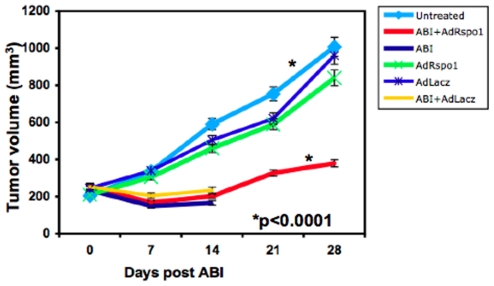
AdRspo1 treatment has no effect on tumor growth.Effect of AdRspo1 and AdLacZ treatment on tumor growth rate of Balb/c mice (n = 5) irradiated with 14Gy ABI. Significant delay in tumor growth (p<0.0001) was observed in ABI groups (Fig A) compared to untreated mice.